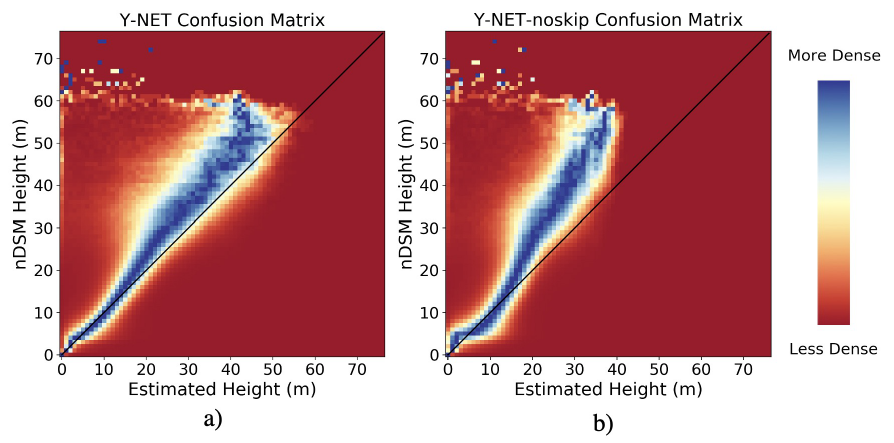
Figure 6. ( a ) Confusion matrix of Y-NET’s estimations. ( b ) Confusion matrix of Y-NET-noskip’s estimations.